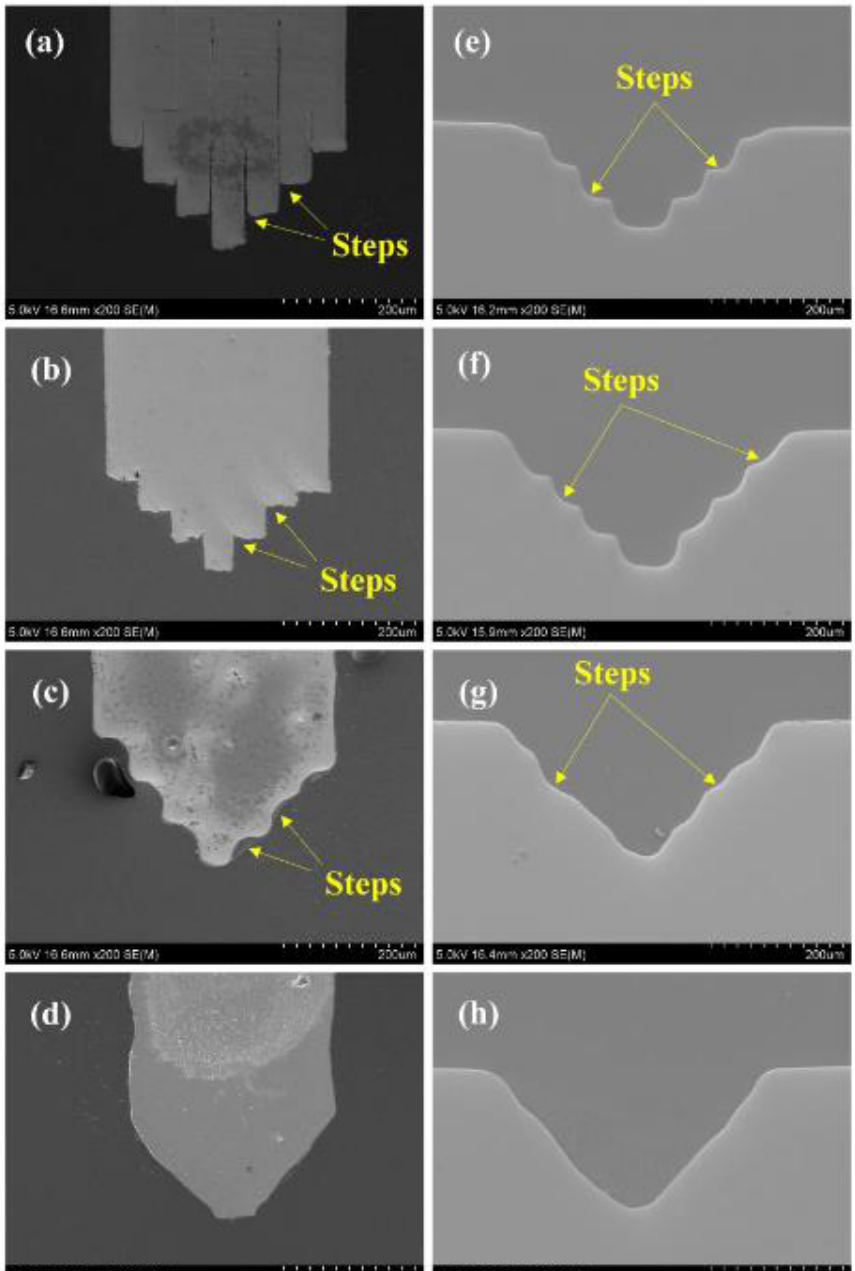
Figure 6. Sectional views of microelectrodes fabricated with different Sn layer thickness: ( a ) 0 μm; ( b ) 1 μm; ( c ) 4 μm; ( d ) 8 μm; ( e – h ) Corresponding sectional views of microstructures machined with these microelectrodes.